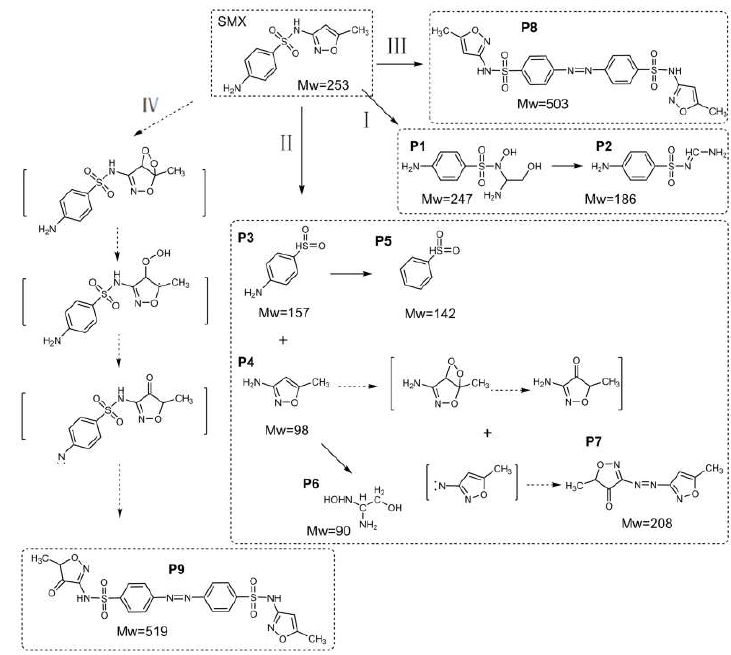
Figure 8. Pathway proposed for SMX degradation by PDS/CuO@CNT.